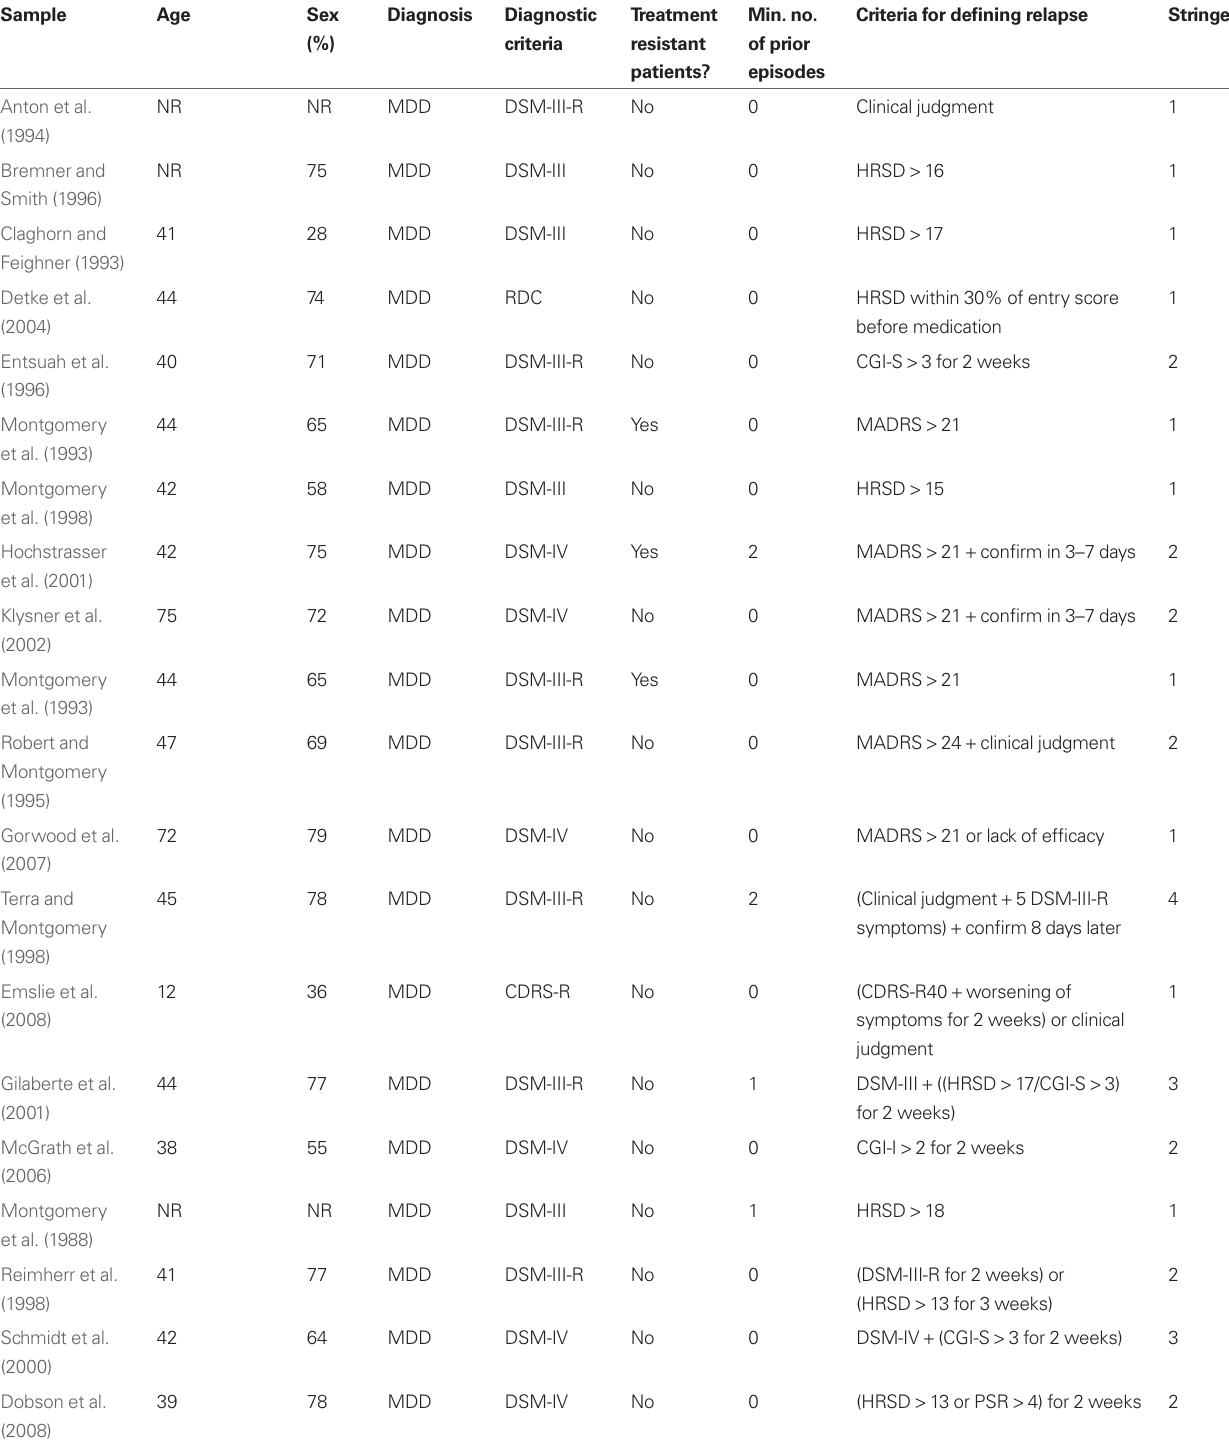
Table A1 | Studies that met inclusion